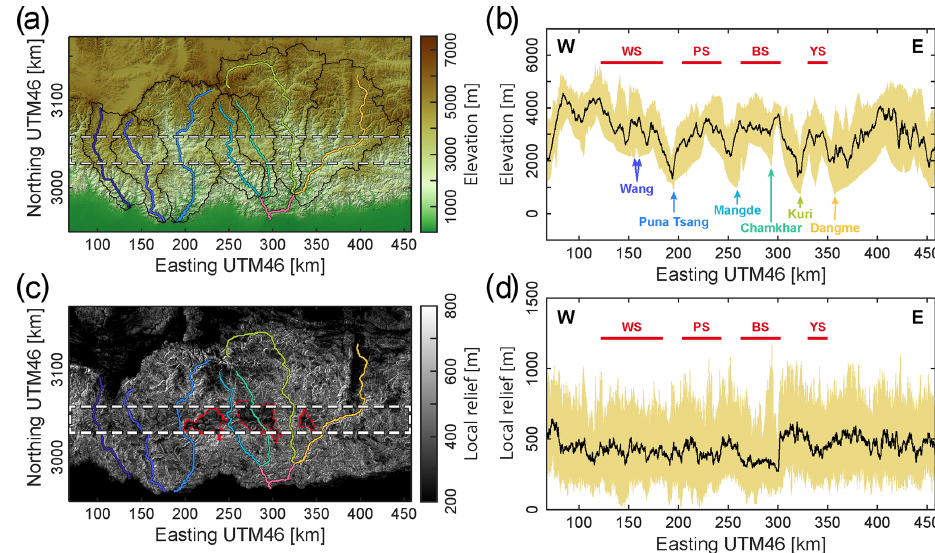
Figure 10. Topography and relief along the hinterland of the Bhutan Himalaya, where low-relief surfaces are located. WS: Wang surface; PS: Phobjikha surface; BS: Bumthang surface; YS: Yarab surface. (a) Topographic map of the Bhutan Himalaya from ALOS World 3D – 30m (AW3D30) DEM data. Main drainage basins are delineated by black lines, and associated main rivers are color-coded (color code as in Fig. 1). The dashed rectangle locates the swath profile represented in (b) . (b) Topographic swath profile along the Bhutan hinterland, with elevations taken within the band illustrated in Fig. 10a. Location of major rivers and of low-relief regions are reported. (c) Map of local relief, as calculated from the topography shown in Fig. 10a, with a moving window of 500m. Major high-altitude low relief areas are delineated by dashed red lines. Main rivers are located and color-coded. The dashed rectangle locates the swath profile represented in (d) and encompasses the same region as that of Fig. 10a. (d) Swath profile of relief along the Bhutan hinterland, with relief taken within the band located in Fig. 10c. Low-relief regions of the mountain range interior are reported. The lower-relief values of the swath profile are to be considered for low-relief